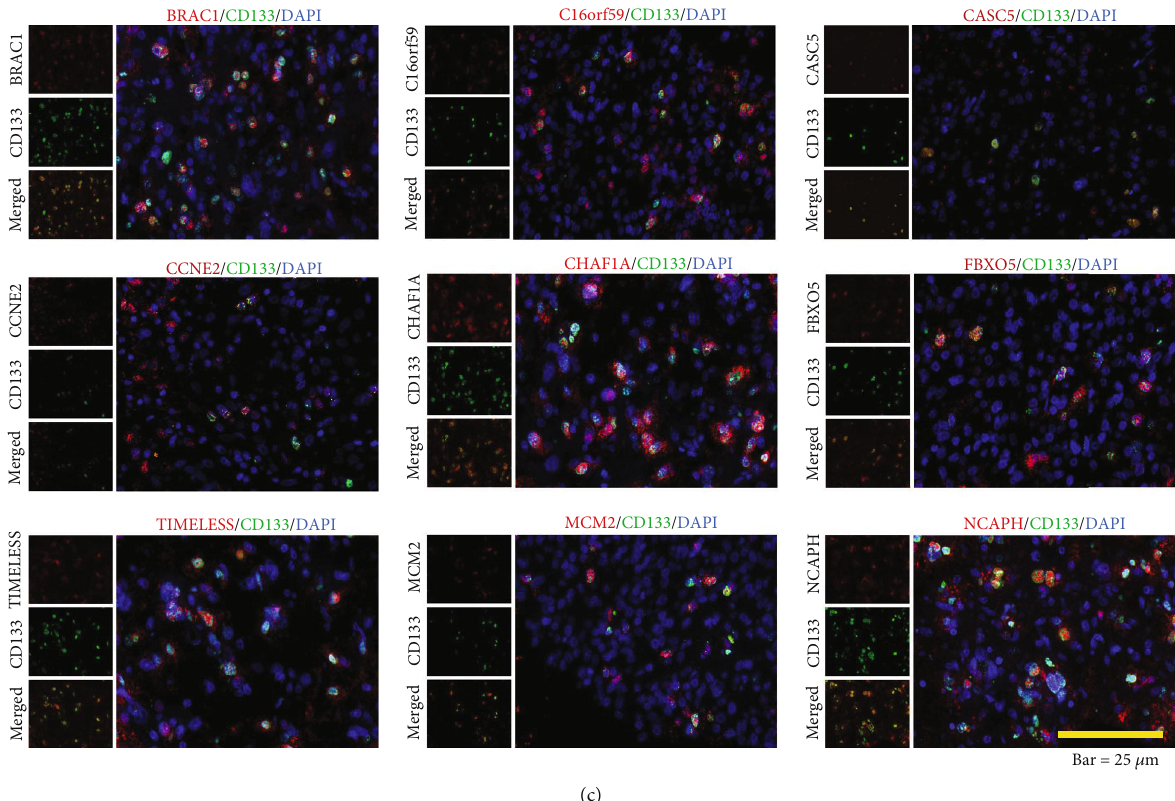
Figure 3: The molecular features of GBM stem cell. (a) Violin plots showing selected marker of GSCL. (b) IHC staining of BRCA1, C16orf59, CASC5, CCNF2, CHAF1A, FBXO5, TIMELESS, MCM2, and NCAPH in GBM samples. (c) Immuno fl uorescence colocalization of selected markers (red) and CD133